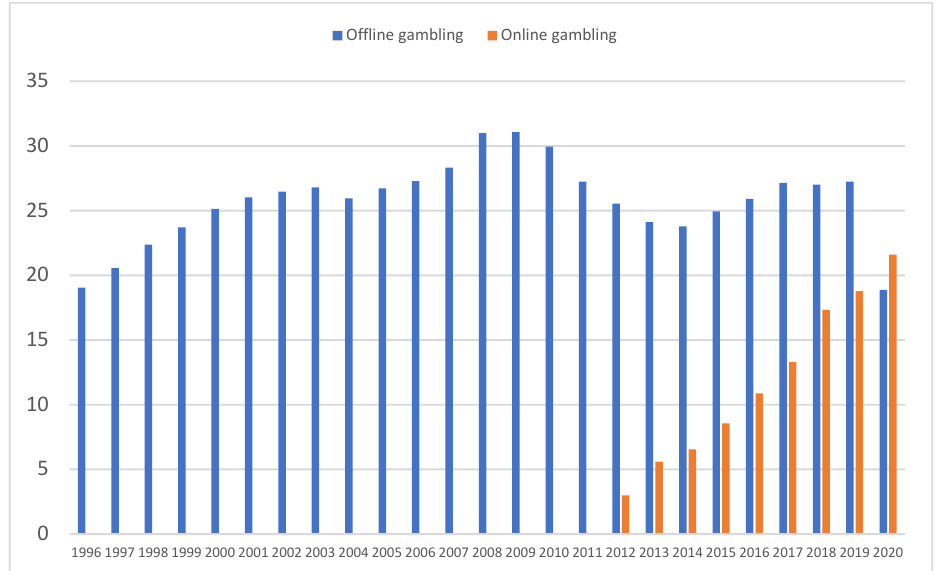
Figure 1. Gambling spending in Spain (1996–2020) (data are billions of Euros).